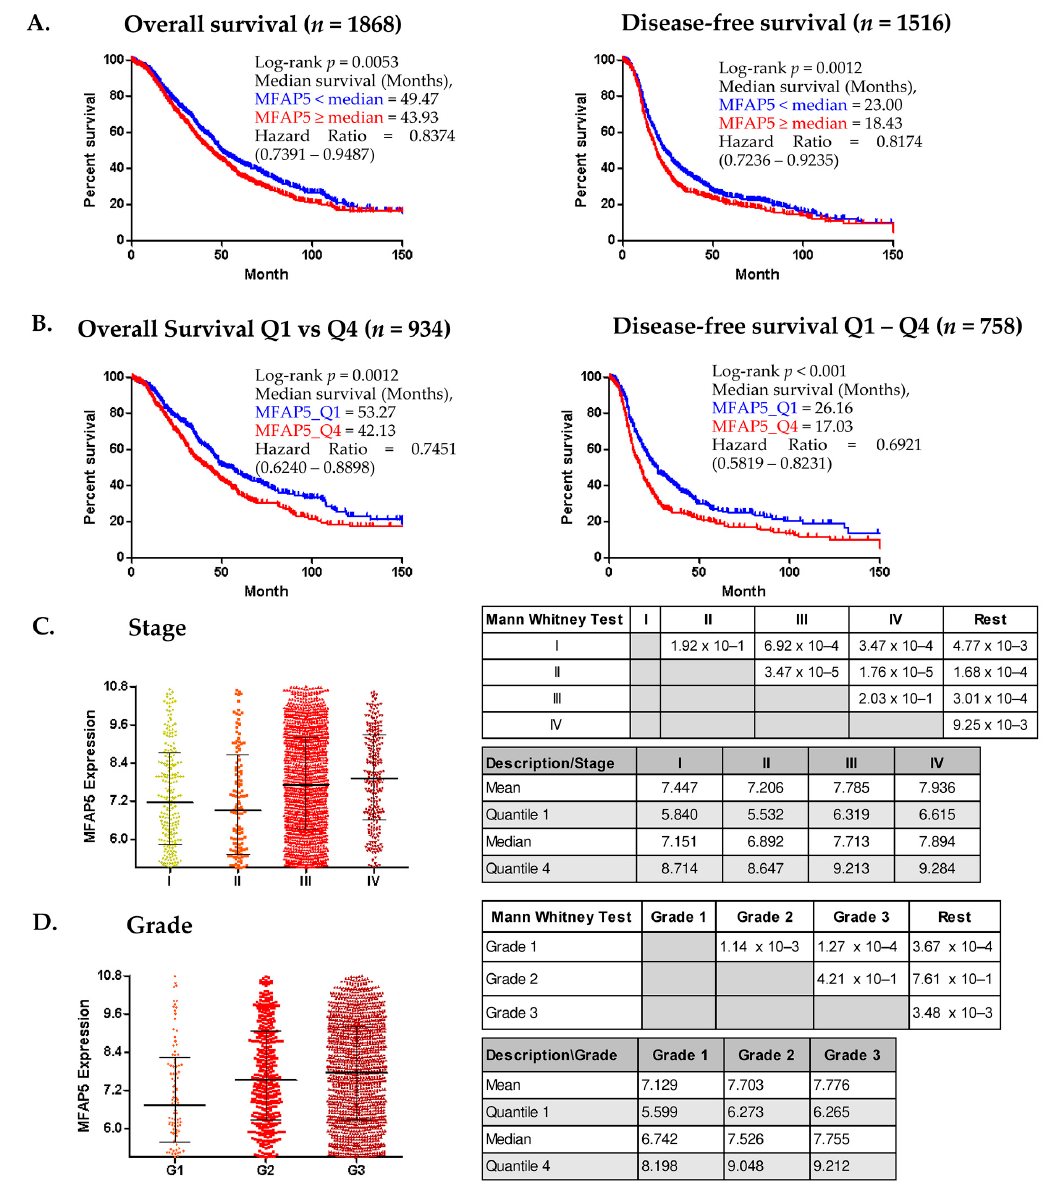
Figure 2. CSIOVDB analyses of MFAP5 mRNA expression. ( A , B ). Kaplan-Meier analysis of survival of ovarian cancer patients stratified according to median MFAP5 expression ( A ) and to the lower and upper quartile (Q1 & Q4) of MFAP5 expression ( B ); ( C , D ) MFAP5 expression plot in relation to FIGO stage and tumor grade. Statistical significance evaluated by Mann Whitney U-test; HR calculated for a reference group with lower MFAP5 expression. (http://csiovdb.mc.ntu.edu.tw/pages/CSIOVDB_ mfap5.html; accessed on 13 June